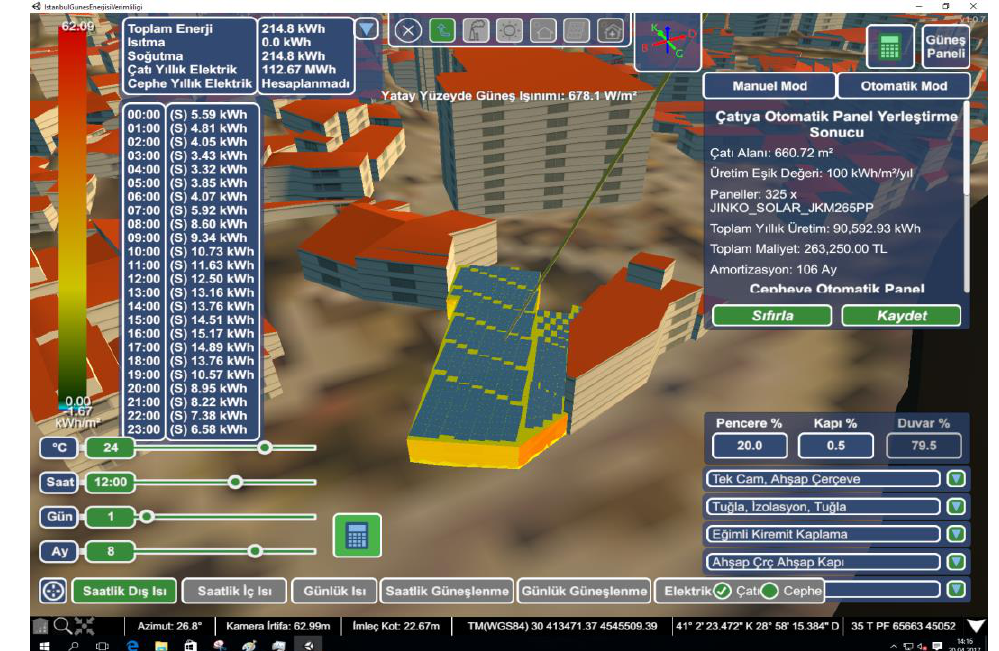
Figure 12. Solar estimation for the selected building